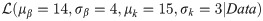
Predicted distributions of set-point viral load (SPVL) among a cohort of patients.(A) Histogram of the observed frequencies of SPVL among seroconverters in the Netherlands (S1 Table). Because of differences in the sensitivities of viral load tests, we pooled all individuals with a viral load less than 103 per ml. (B) Maximum log-likelihood distribution of SPVLs for the single patch model given the Netherlands seroconverter data, with log L(μβ=14,σβ=4,μk=15,σk=3|Data) = -5386. (C) Maximum log-likelihood distribution of SPVLs for the 10,000 patch metapopulation model given the Netherlands seroconverter data, with log L(μβ=14,σβ=4,μk=15,σk=3|Data) = -4,013. For (B) and (C), viral infectivity, β, and the maximum CTL immune response, k, are assumed to be distributed according to truncated normal distributions, with probability density functions f (β; μβ,σβ,βmin,βmax) and f (k; μk,σk,kmin,kmax), respectively, where βmin = 1.05 per day, kmin = 0 per day, and βmax = kmax = 20 per day (see S1 Text). For both the metapopulation and single patch models, a viral reservoir is assumed to be present and the effective migration rate is assumed to be high (Me = 2.4 per day). All other parameters are as described in Table 1.